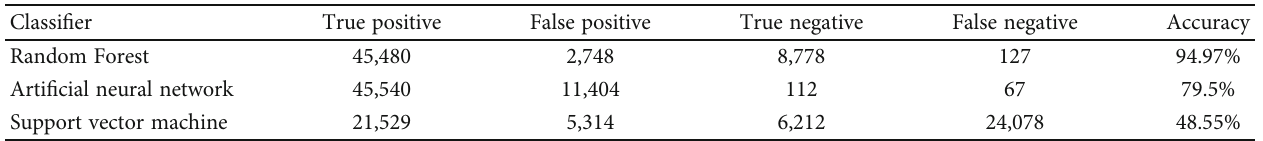
Table 4: 10-fold cross-validation